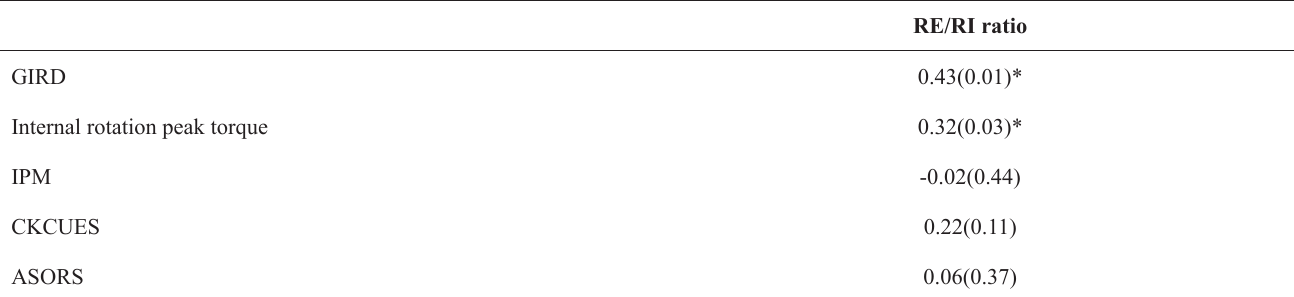
Table 2 - ER/IR ratio Pearson’s correlation coefficients [r(p)] (n = 34).